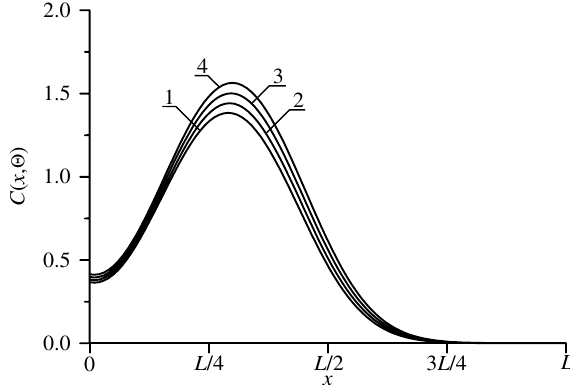
Fig. 2 Typical distributions of concentration of dopant at different values of dose of implanted ions.